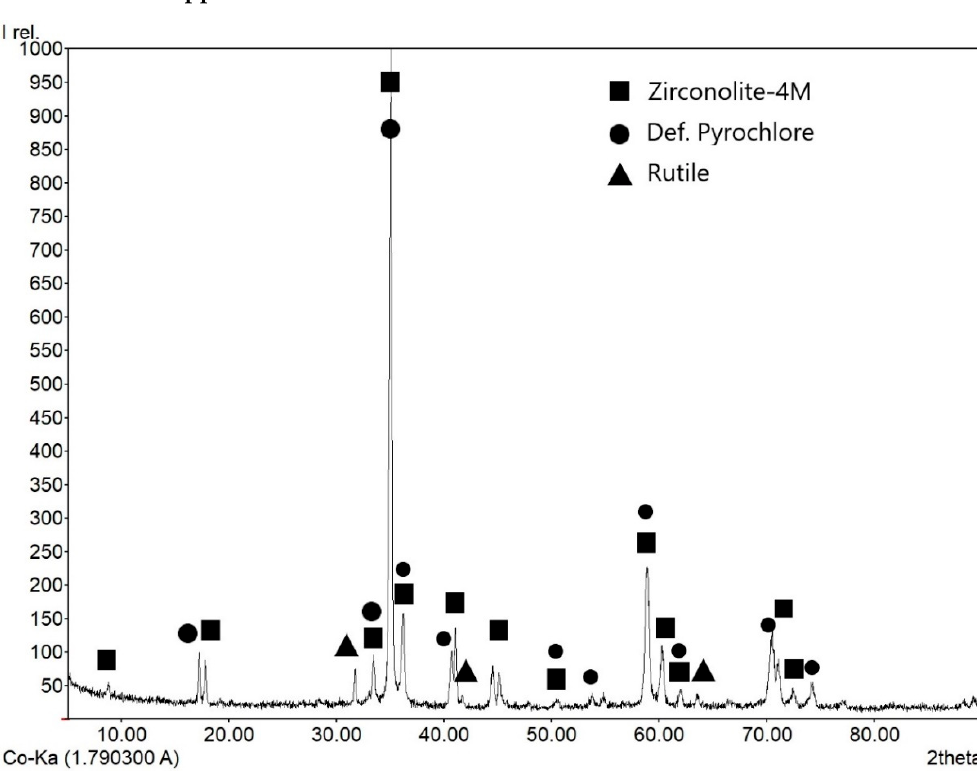
Figure A1. X-ray diffraction pattern of the sample “Th”.